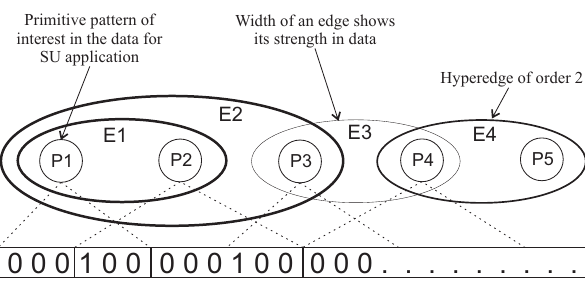
Figure 2. Hypernetwork with 4 hyperedges and 5 patterns